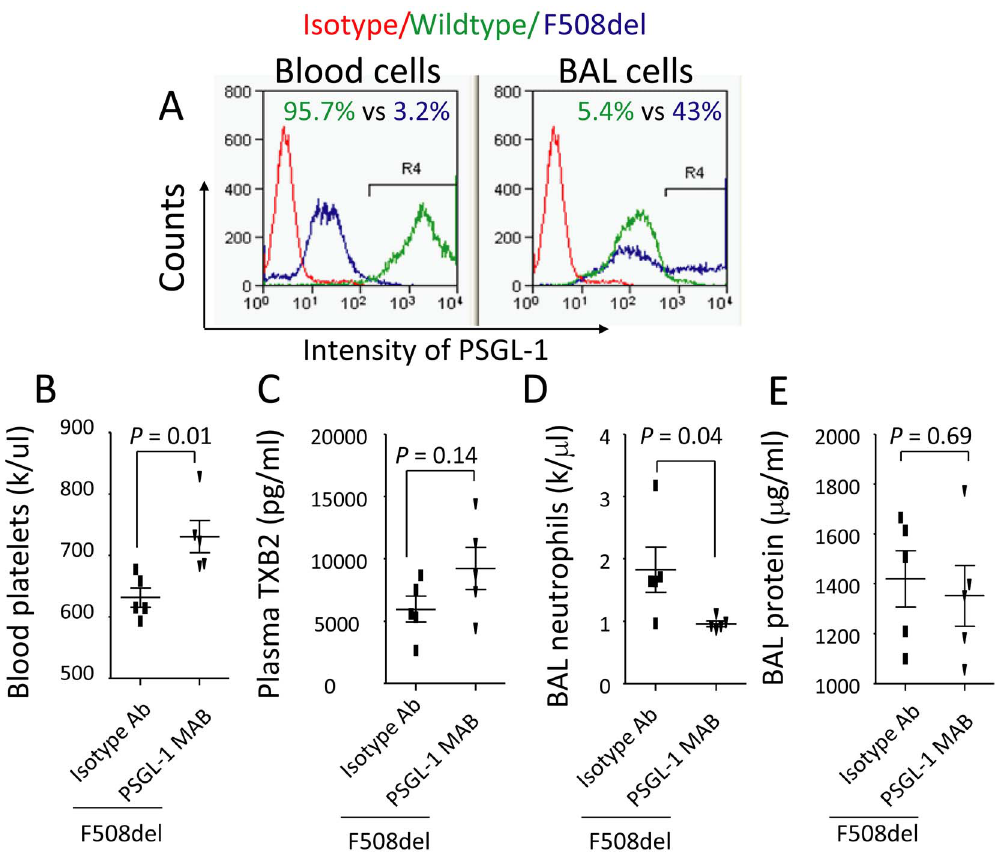
Figure 5. Blockade of PSGL-1 prevents thrombocytopenia and neutrophil transalveolar migration in F508del mice. A . Analysis of PSGL-1 + leukocytes in blood and BAL cells by flow cytometry. Cells were isolated from wild-type and F508del mice after LPS challenge at 24 h and then stained with PE anti-PSGL-1 antibody. B–C . Blockade of PSGL-1 reversed thrombocytopenia induced by LPS in F508del mice ( B ), but did not affect plasma TXB2 levels ( C ). D . Blockade of PSGL-1 reduced BAL neutrophils in F508del mice, but did not affect BAL protein levels ( E ). N=5 in each group. Data were analyzed by t-test and presented in mean 6 SD. P values are listed on each panel.